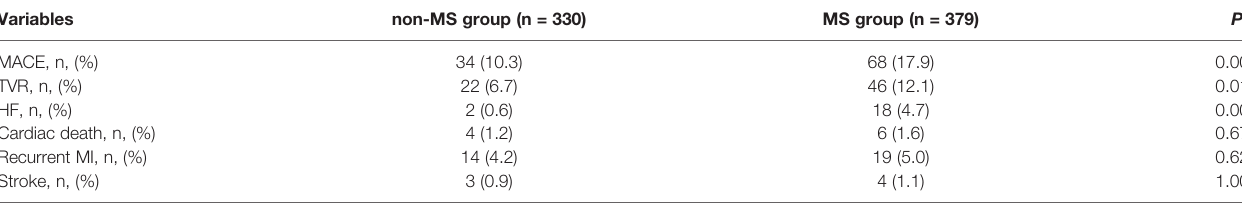
TABLE 2 | Comparison of clinical outcomes between MS group and non-MS group. Variables